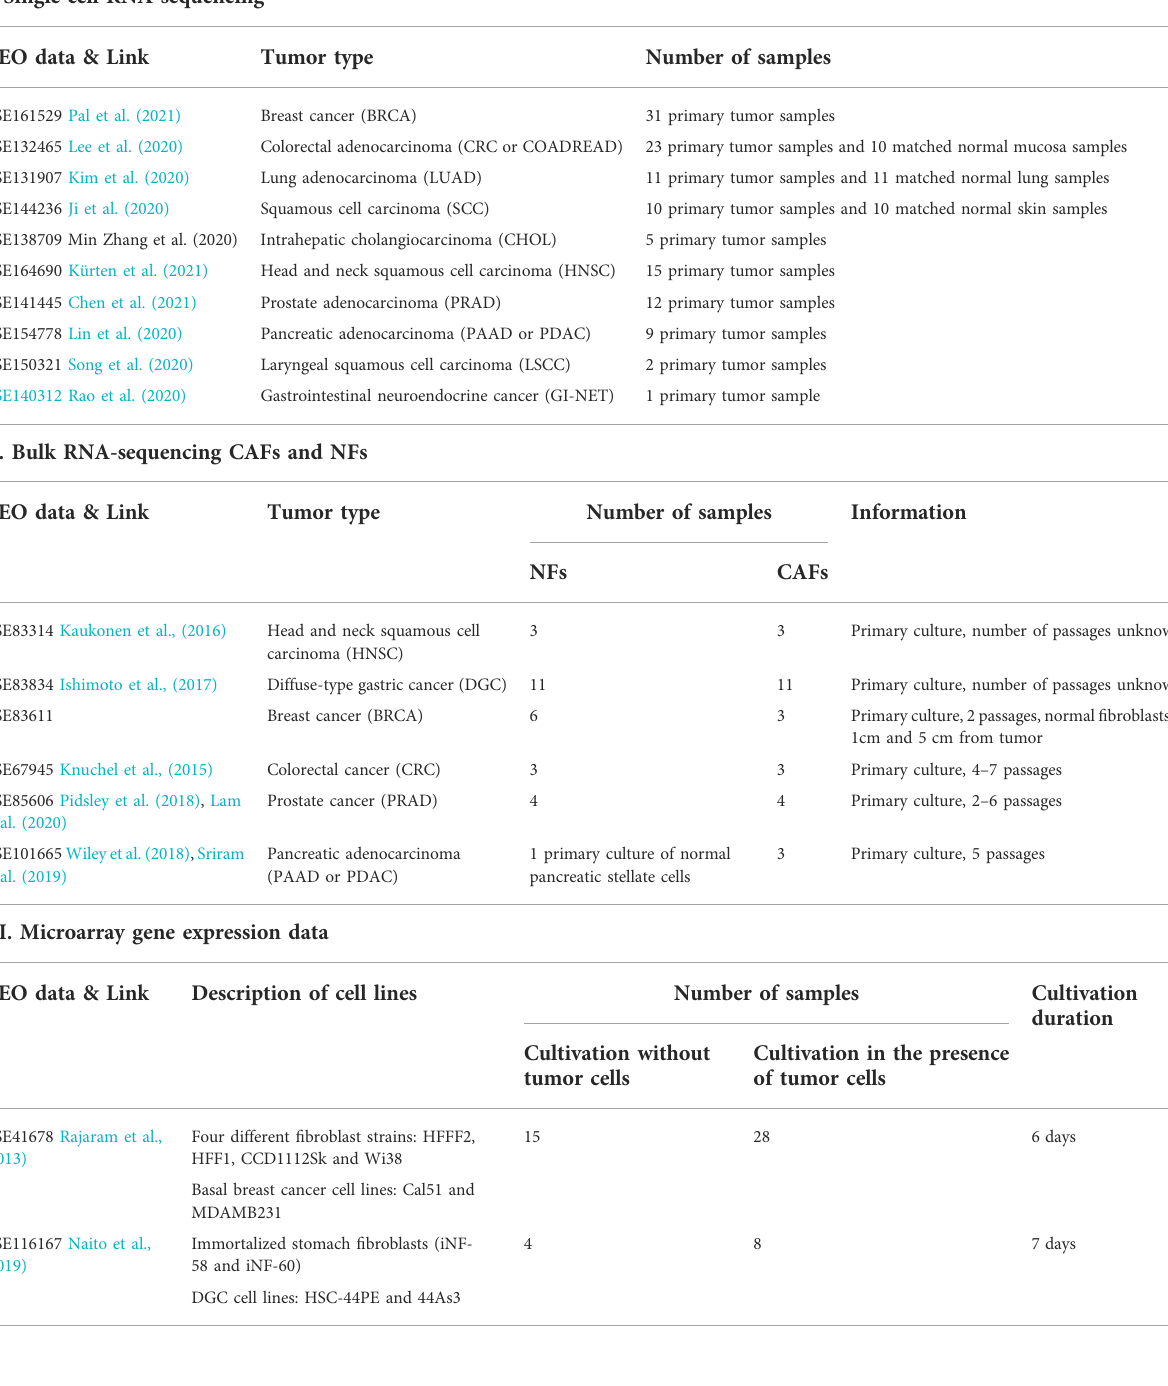
TABLE 1 RNA-Seq data used in this study. The dataset title is used here as a dataset identi fi